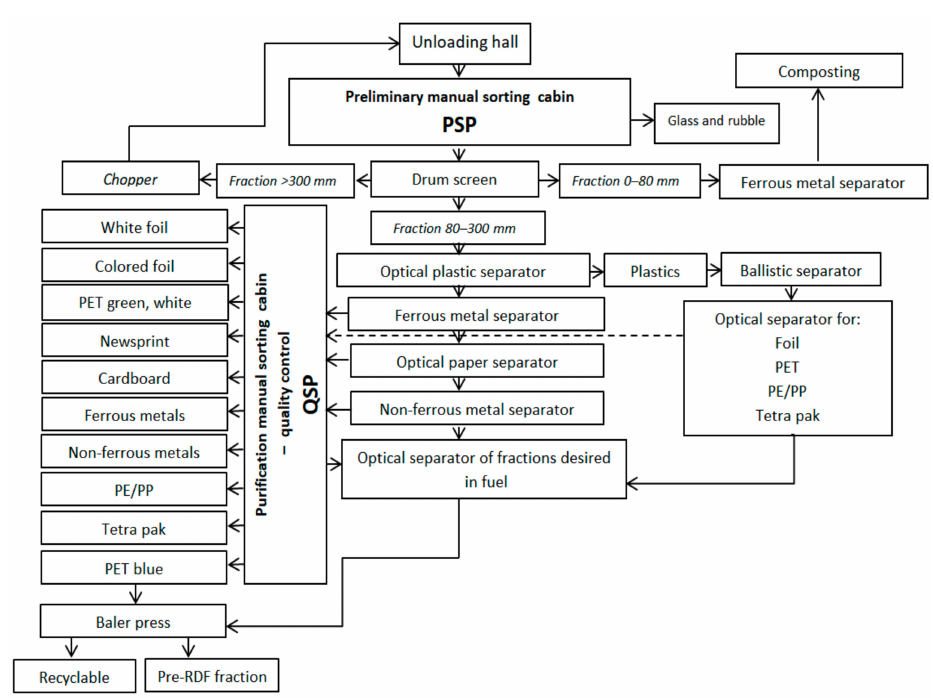
Figure 1. Scheme of the analyzed waste-sorting plant